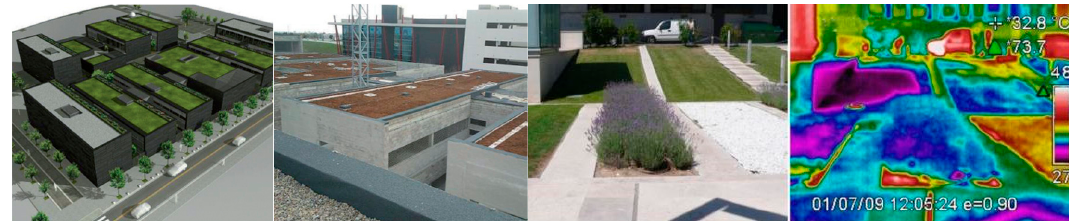
Figure 4. Sustainable drainage urban systems (SUDS) to reduce the urban heat island (UHI). Model and development of green roof on the Parc Bit building, Palma de Mallorca, Spain. Example of thermography to track the UHI